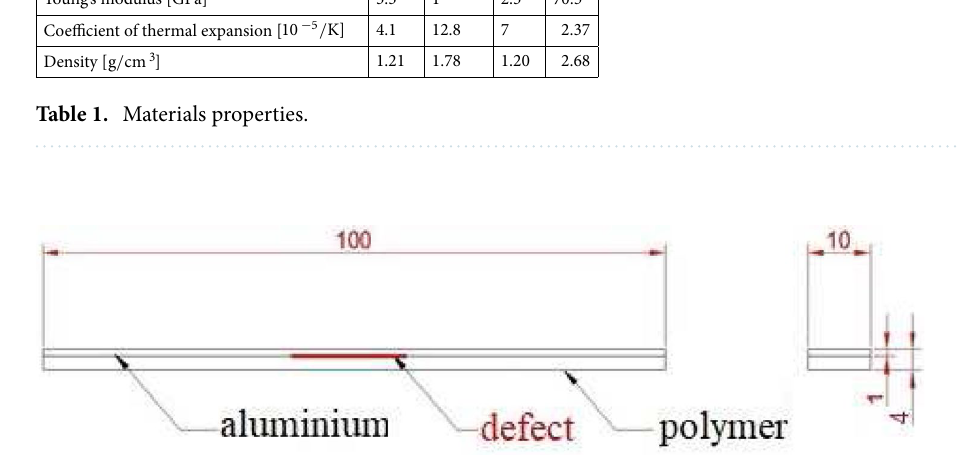
Figure 1. Sideview of a sample with a defect indicated; sizes are in